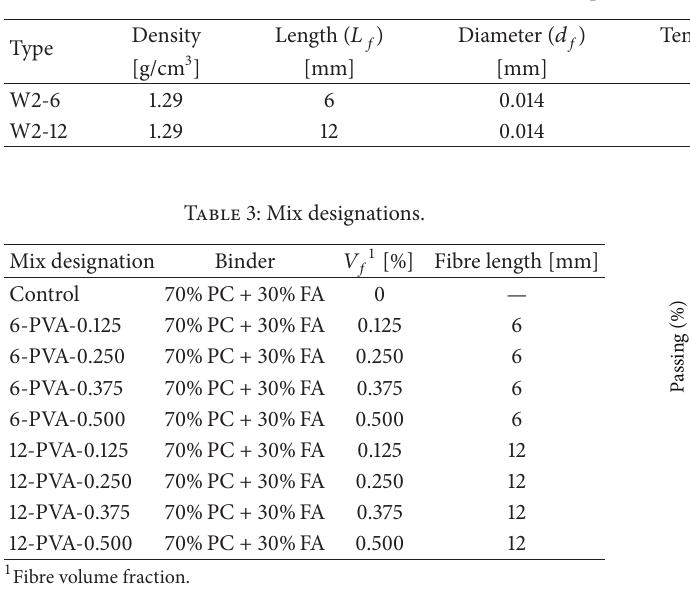
Table 2: Properties of PVA fibres.